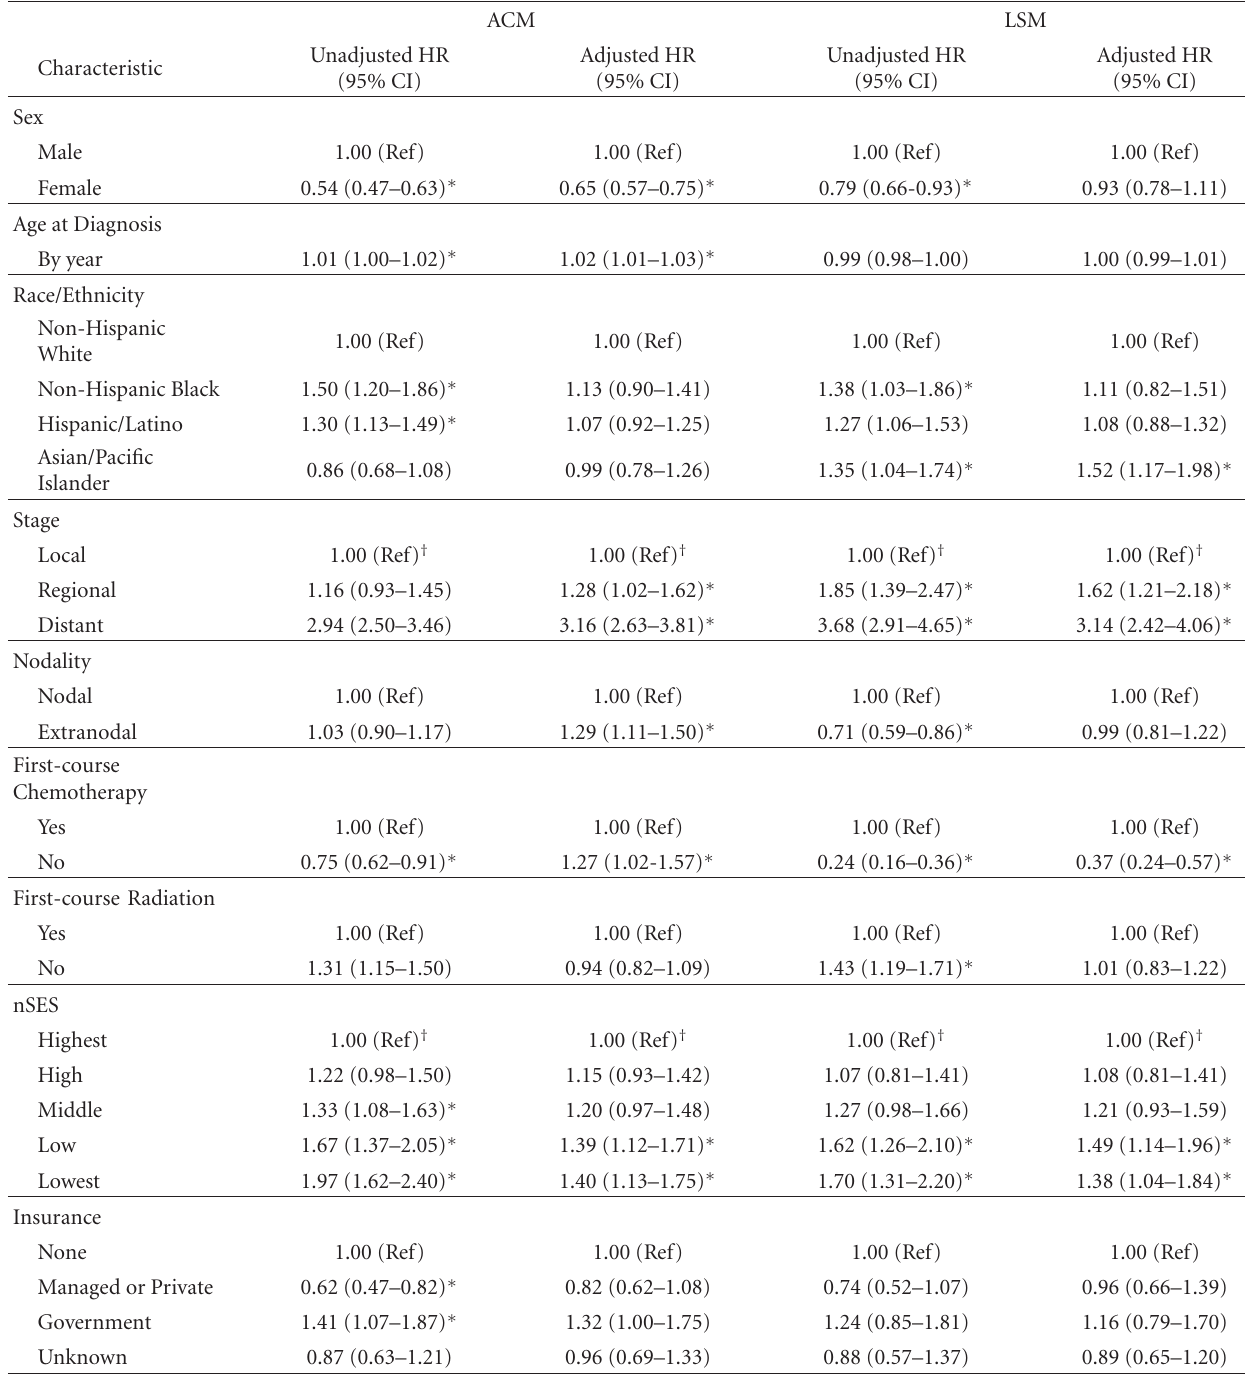
Table 2: Multivariate hazard ratios a for all-cause mortality b and lymphoma-specific mortality c using Cox Proportional Hazards model for adolescent and young adult non-Hodgkin’s lymphoma